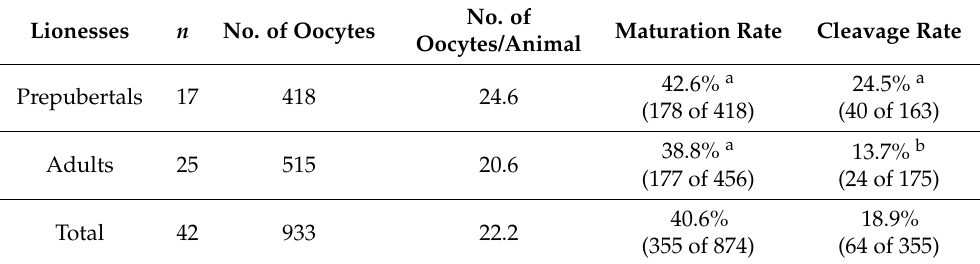
Table 3. Outcome of IVM and IVF from lion oocytes obtained from prepubertal (<2 years) and adult